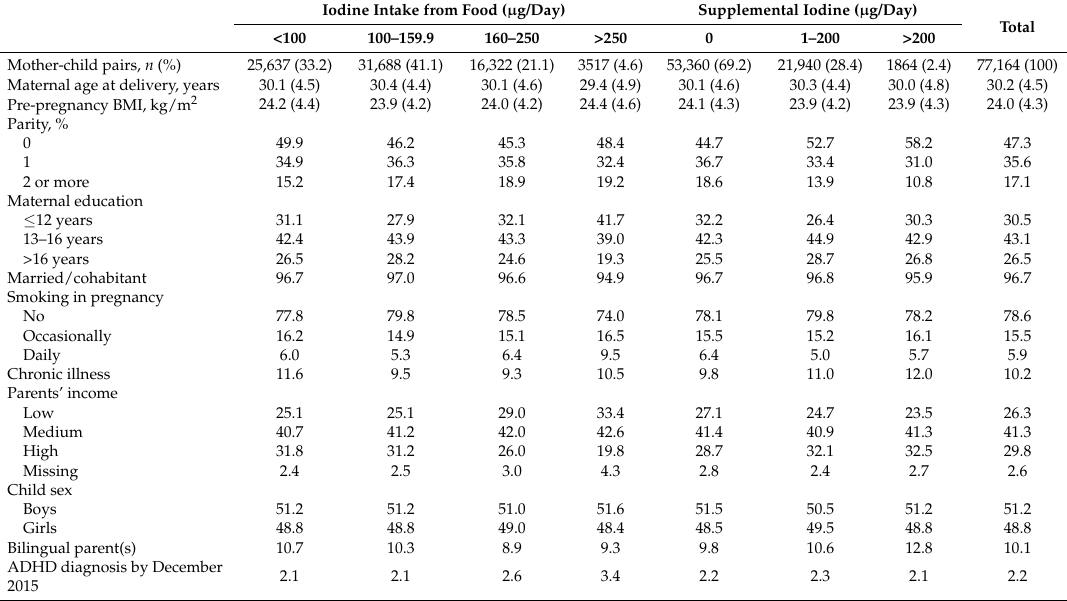
Table 1. Maternal and child characteristics by maternal iodine intake from food and from supplements in first half of pregnancy 1